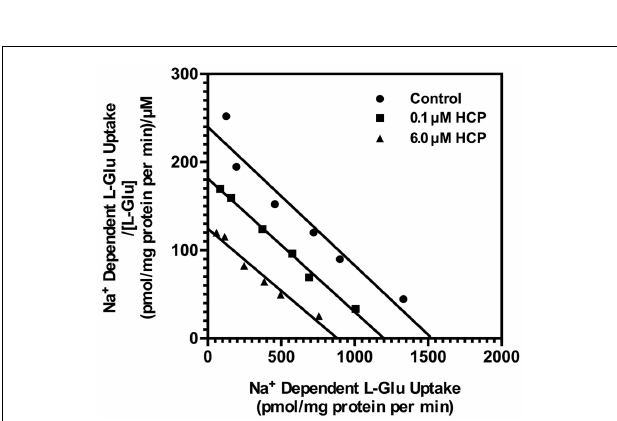
FIGURE 3 | Effects of pre-incubation with HCP (6 µ M) on Na + -dependent L -[ 3 H]-glutamate transport into crude membranes (P2) prepared from cortex . HCP (or vehicle) was added to crude membranes (P2) at 37°C at 1, 3, 5, 10, or 15min prior to the initiation of transport with the addition of L -[ 3 H]-glutamate, or simultaneously with L -[ 3 H]-glutamate (time = 0min). Percent of control represents the velocity of transport in the presence of inhibitor divided by that observed in the absence of inhibitor multiplied by 100. Data are the mean ± SEM of at least three independent measurements.